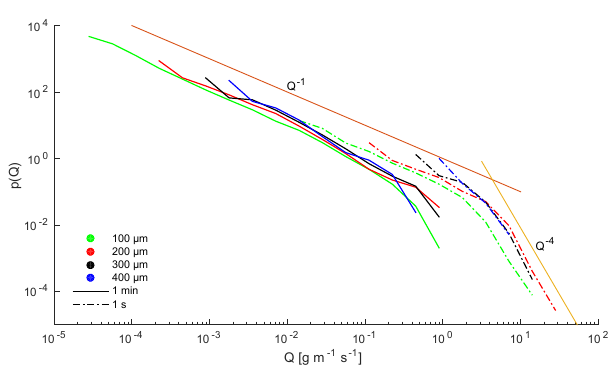
Figure 4. Probability density functions of Q 1s (solid lines) and of Q 1min (dashed lines) for four different particle sizes. Two addi- tional lines p(Q) ∼ Q − 1 and Q − 4 are drawn for